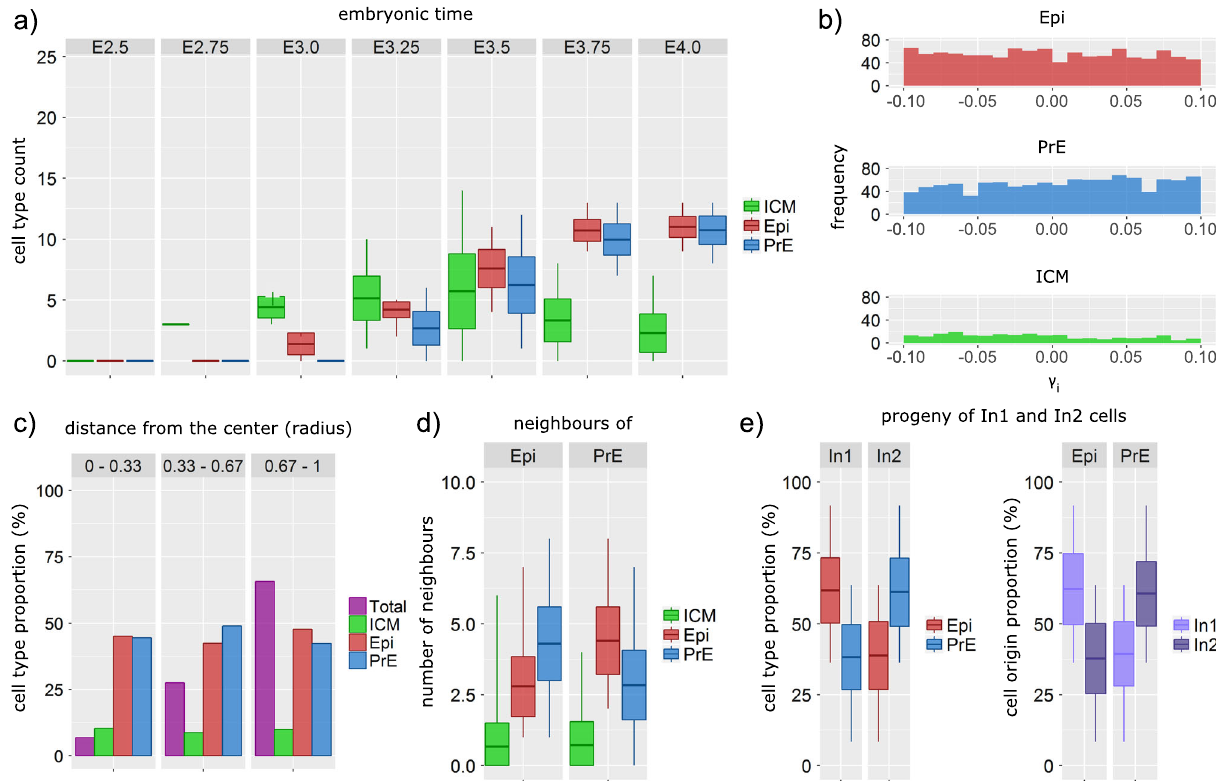
Fig. 3 Analysis of the simulated embryos with the default values of parameters given in Supplementary Tables S1 – S3. The analysis is done for a sample of 100 simulated embryos. a Evolution of ICM, Epi and PrE by cell count from E2.5 to E4.0. The darker lines in the boxes show the mean values, the boxes show the standard deviation, whereas the vertical lines indicate the minimal and maximal value of the sample. b Distribution of the fi nal random parameter γ i for each of the three cell fates — epiblast ( Epi, red ), primitive endoderm ( PrE, blue ) and inner cell mass ( ICM, green ) showing the absence of correlation between the fi nal value of γ i and the cell fate. c Spatial distribution of each cell type at various distances from the centre of the embryo. The distances are normalised by the radius of the embryo. The total number of cells (magenta) shows how many cells were observed at each layer compared with the number of cells in the whole embryo. d Number of neighbouring cells by type surrounding Epi (left) and PrE cells (right), showing that Epi cells are surrounded by more PrE cells than by cells of their own type, and vice versa. e On the left hand side — the proportions of Epi and PrE cells in In1 and In2 cell progeny. On the right hand side — the proportions of In1 and In2 originating cells in the fi nal Epi and PrE cell